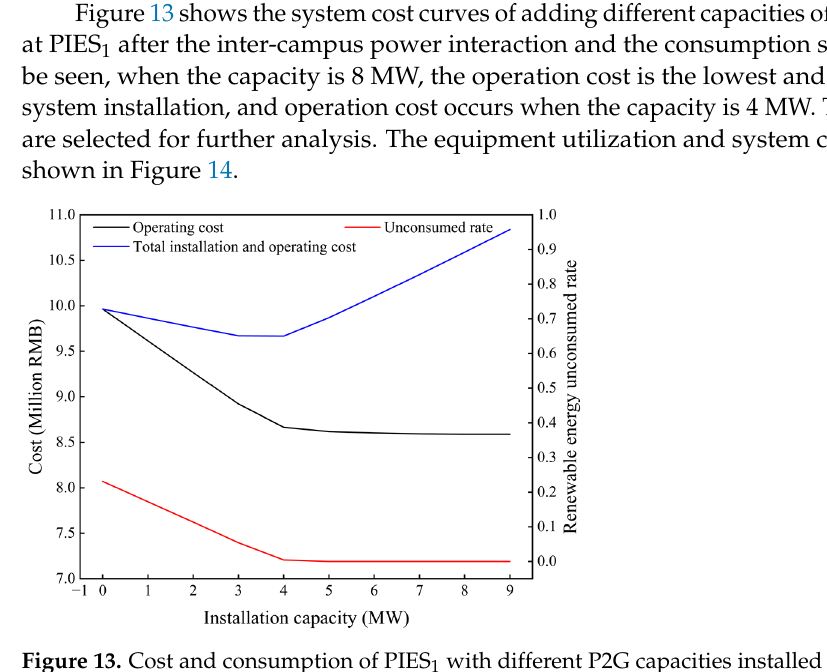
Figure 13. Cost and consumption of PIES 1 with different P2G capacities installed in Scenario 4.